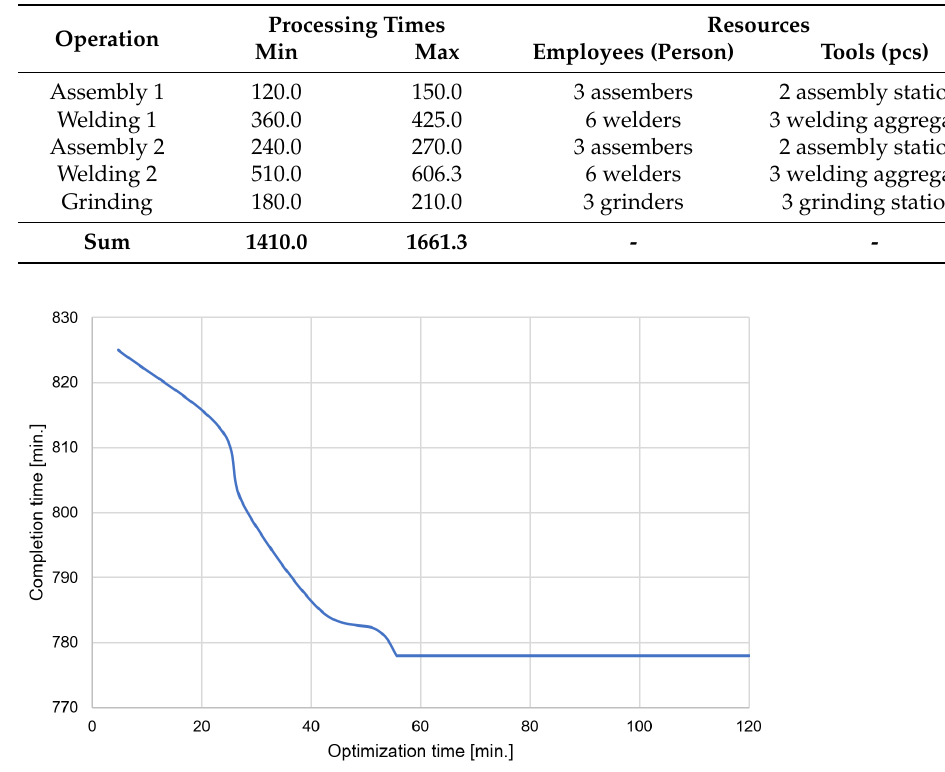
Figure 6. Progress in minimizing the time completion criterion for the scraper conveyor chute production